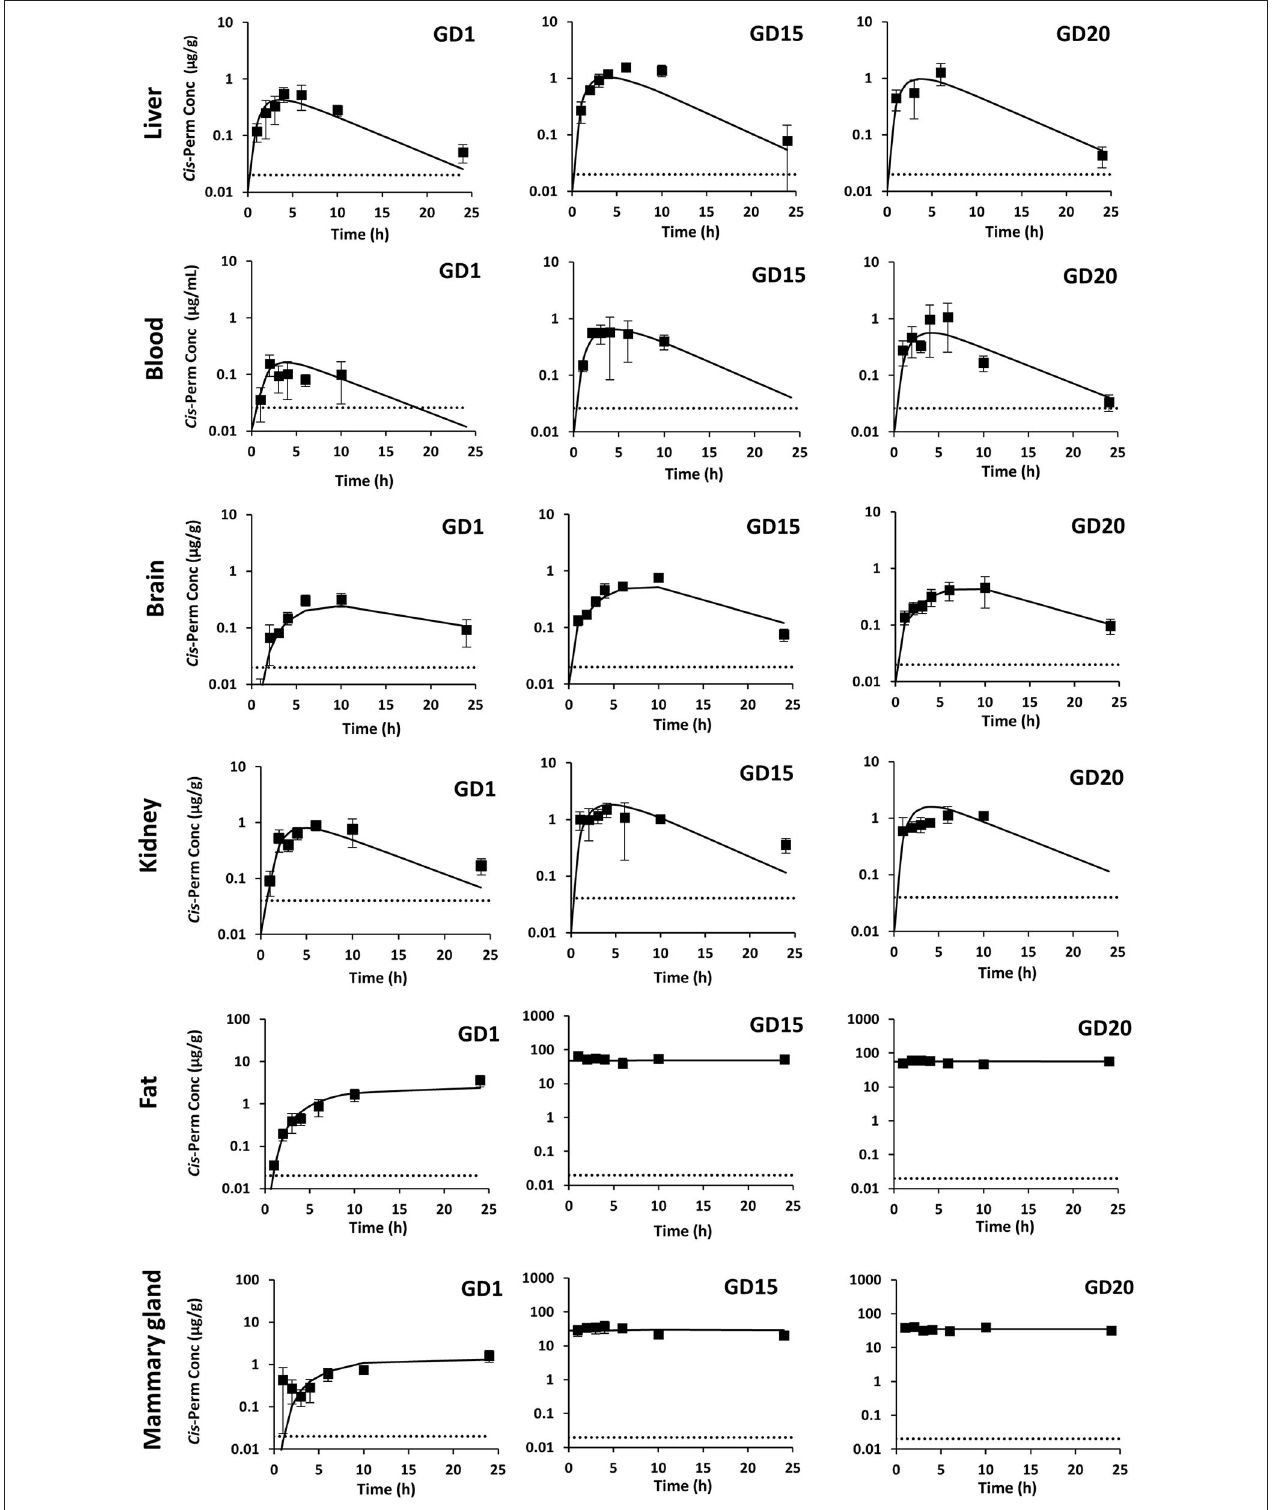
FIGURE 2 | Measured concentrations (squares) and toxicokinetic profiles estimated with the physiologically based pharmacokinetic model (solid line) of cis -permethrin in pregnant rats at GD1, GD15, and GD20. The gray dotted line stands for the limit of quantification.